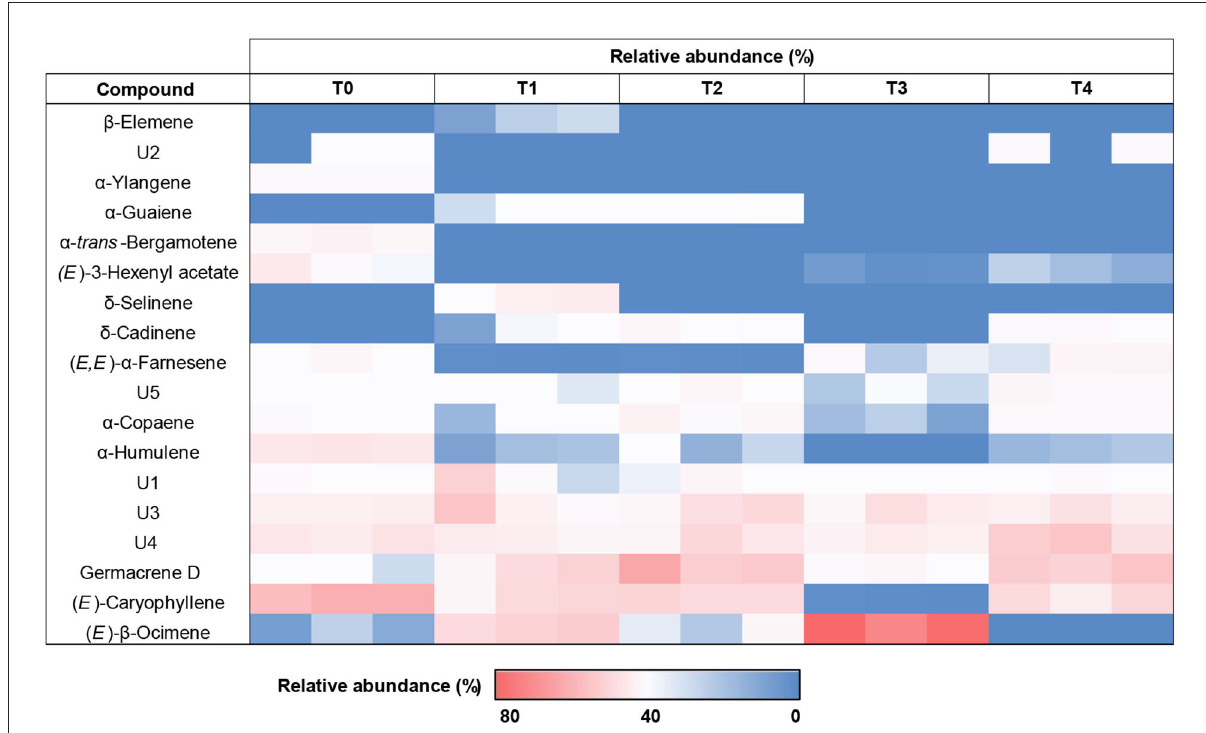
FIGURE10 Clustered heat map based on increasing average relative abundance (%) of the volatile compounds (identified and unknown) in the leaf extracts of H 2 O 2 treated F. deltoidea and untreated plants under drought